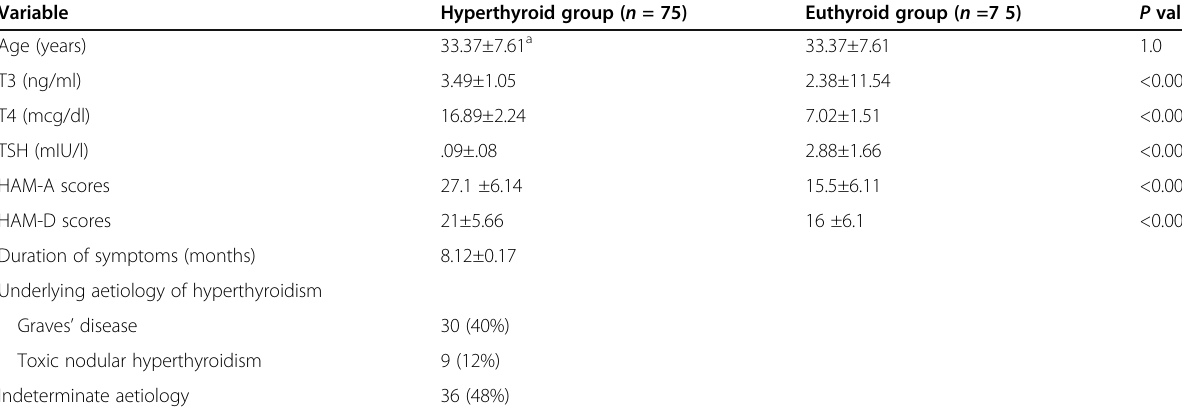
Table 1 Clinical and laboratory variables among cases and controls ( n =